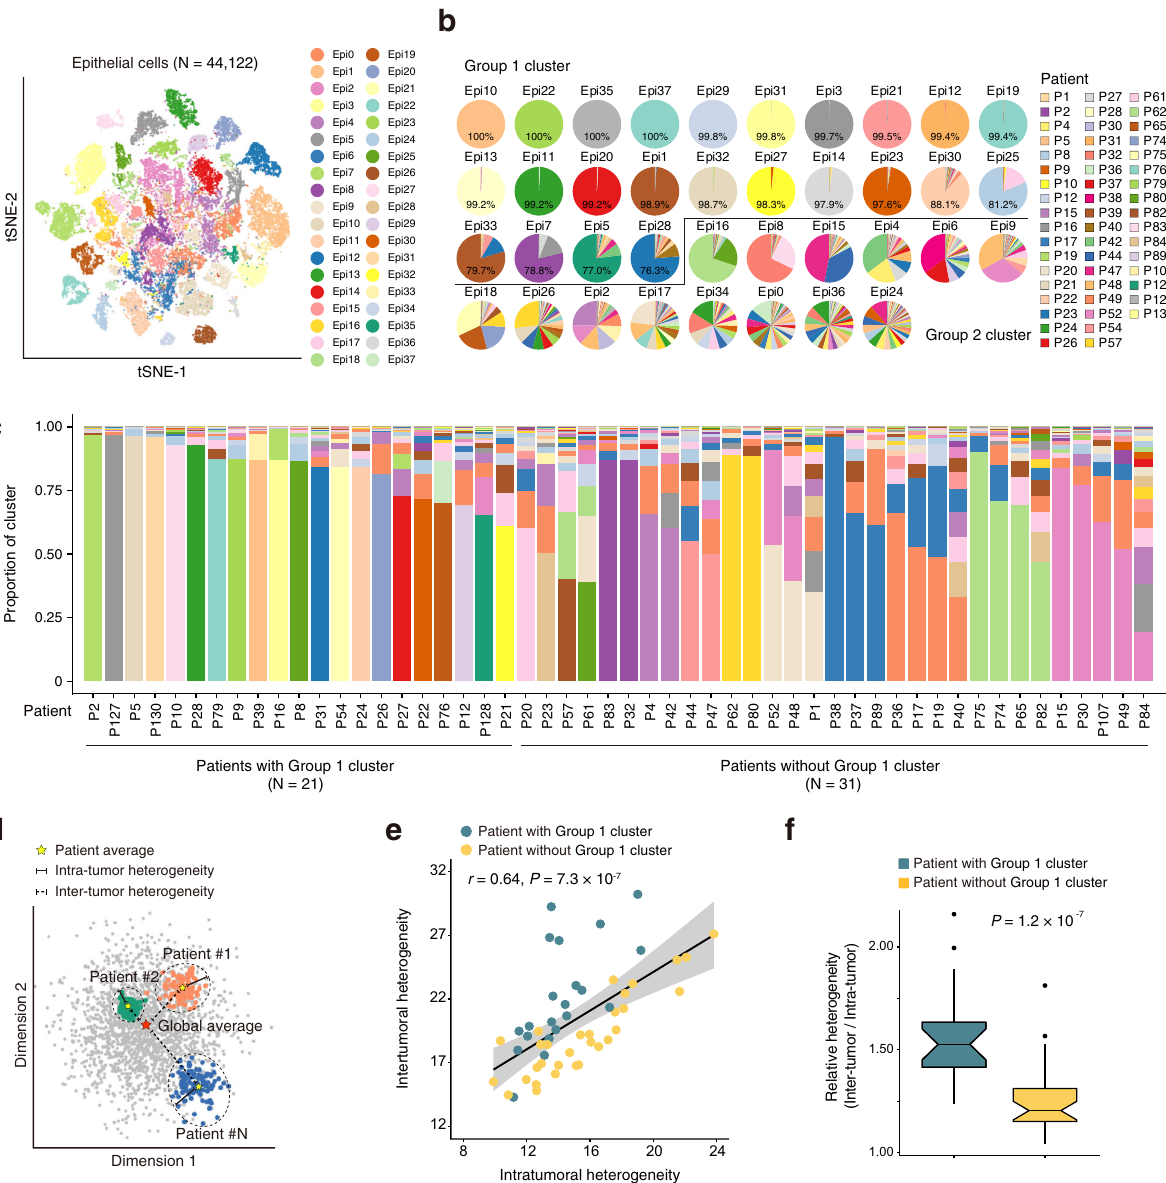
Fig. 2 Correlation between intra- and inter-tumor heterogeneity of epithelial cells. a tSNE plot of 44,122 epithelial cells, colored by cluster. Only tumors with at least 100 epithelial cells are shown. b Pie charts showing the proportions of cells originating from each patient detected in each cluster, colored by patient. Clusters are ordered by the proportion of the most dominant patient and are classi fi ed into Group 1 cluster or Group 2 cluster. c Stacked histograms showing proportions of epithelial cell clusters for each patient, colored by cluster as in ( a ). d Schematic showing the methods for quantifying the intra-tumor (solid line) and inter-tumor (dashed line) heterogeneities of epithelial cells for each patient based on the patient average (yellow star) and global average (red star). e Scatterplot showing the positive correlation between the intra- and inter-tumor heterogeneities. Two-sided Spearman correlation coef fi cient and P value are indicated. Shaded region indicates 95% con fi dence interval for the correlation. f Boxplot showing the relative inter- tumor heterogeneity levels for patients with Group 1 cluster (green) or without Group 1 cluster (yellow). Boxplots show the median (central line), the 25 – 75% interquartile range (IQR) (box limits), the ±1.5 times IQR (Tukey